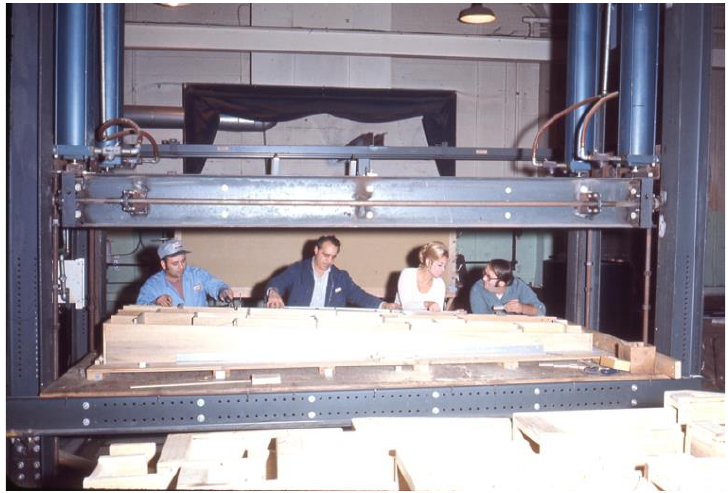
Figure 3 Photographer unknown, Artist Aaronel deRoy Gruber and technicians preparing to lower vacuum-forming and heated press at Engineered Products Inc., Pittsburgh, PA., PA ., approximately 1970. Digitized photograph. Image courtesy of the Irving and Aaronel deRoy Gruber Foundation,